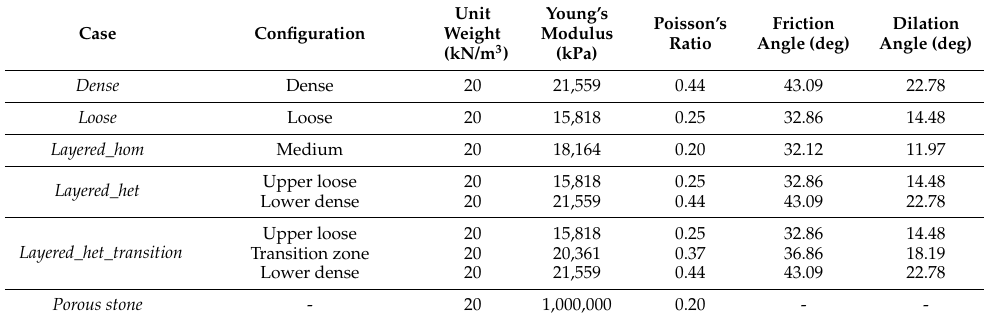
Figure 11. Finite element models to reproduce different sand specimen configurations: ( a ) dense specimen ( dense ), ( b ) loose specimen ( loose ), ( c ) half-dense half-loose specimen modeled as a homoge- neous material ( layered_hom ), ( d ) half-dense half-loose specimen modeled as a heterogeneous material ( layered_het ) ( e ) half-loose half-dense specimen modeled as a heterogenous material considering a transition zone between the loose and the dense specimen’s segments ( layered_het_transition ). Table 2. Summary of material properties for dense, loose, and layered